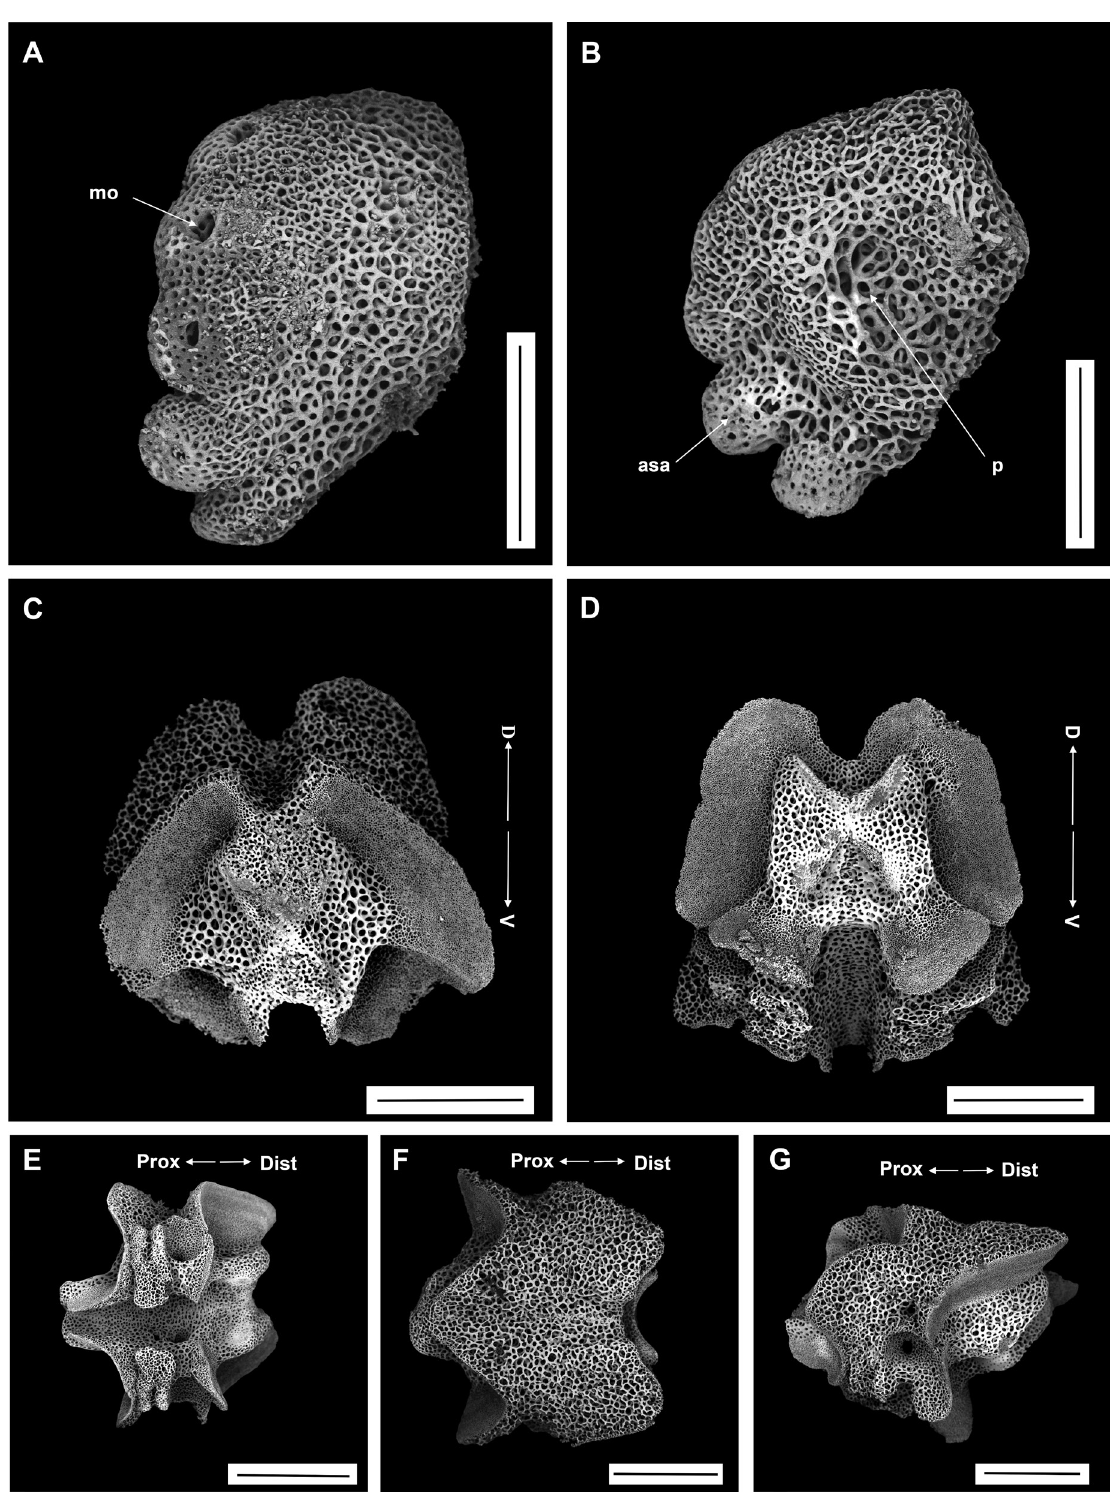
Fig. 3. Asteronyx loveni Müller & Troschel, 1842, SEM (IDSSE EEB-SW0002). A–B . Lateral arm plates (external, internal). C–G . Vertebrae. C . Proximal view. D . Distal view. E . Ventral view. F . Dorsal view. G . Lateral view. Abbreviations: asa = arm spine articulation; D = dorsal; Dist = distal; mo = muscle opening; p = perforation of inner side; Prox = proximal; V = ventral. Scale bars: A–B = 300 µm; C–D, F–G = 500 µm; E = 800